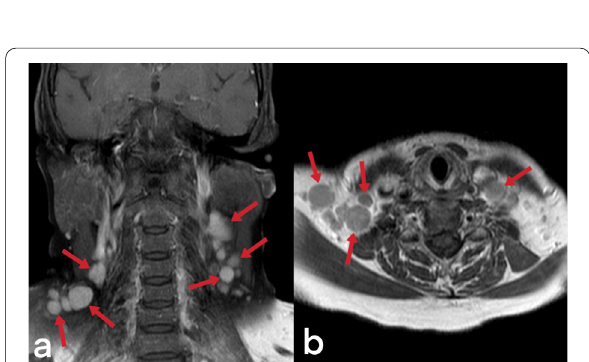
Fig. 10 Contrast-enhanced T1 weighted coronal ( a ) and axial T1 weighted ( b ) MR images of a 44-year-old female demonstrate multiple lymphadenopathies in the bilateral cervical chains and right supraclavicular region. Multiple intraabdominal lymphadenopathies are also noted (not shown)